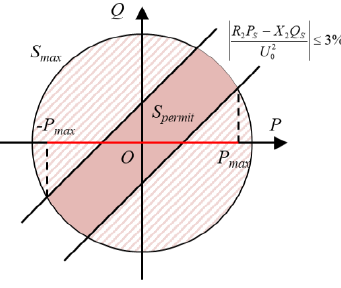
Figure 8. Transmission power boundary of SOP.